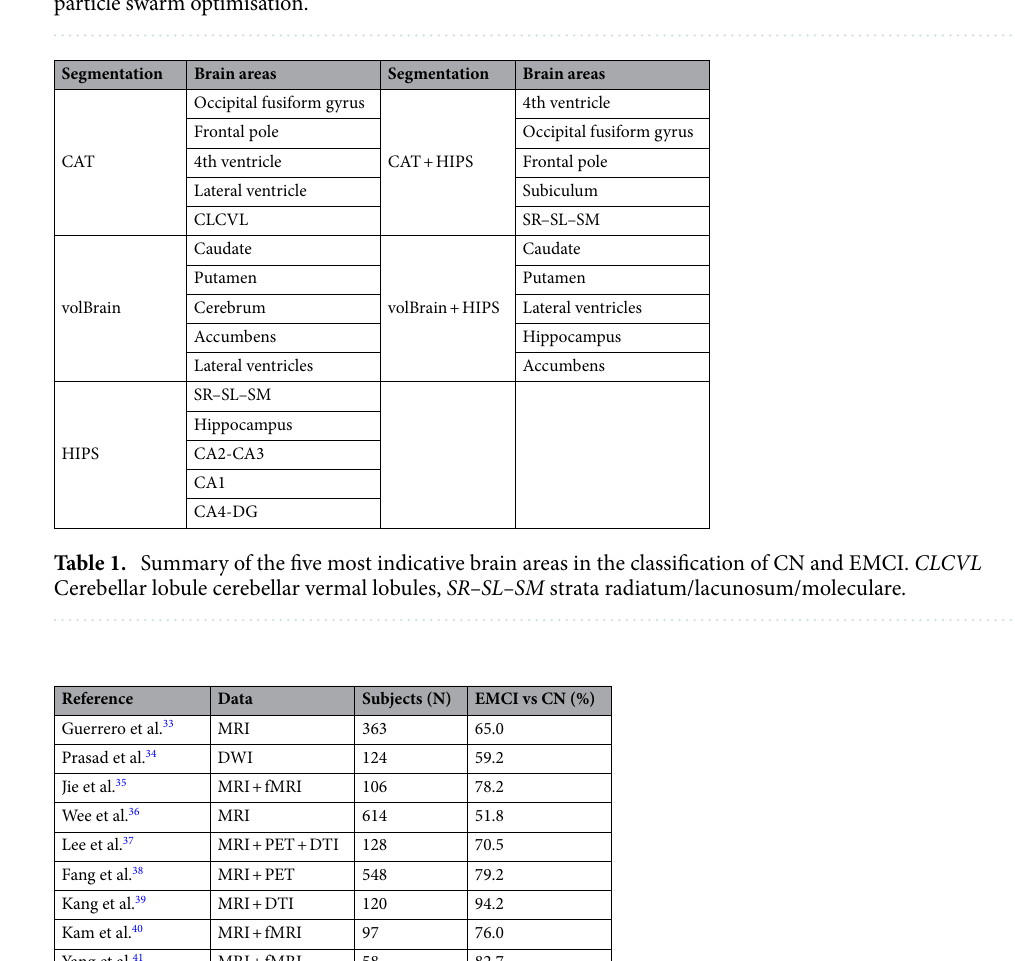
Figure 2. Comparison of the five evolutionary algorithms (EA) in terms of accuracy ( a ) and processing time ( b ). Values reported are mean (SD) difference compared to the average of the five EAs. GA Genetic algorithm,